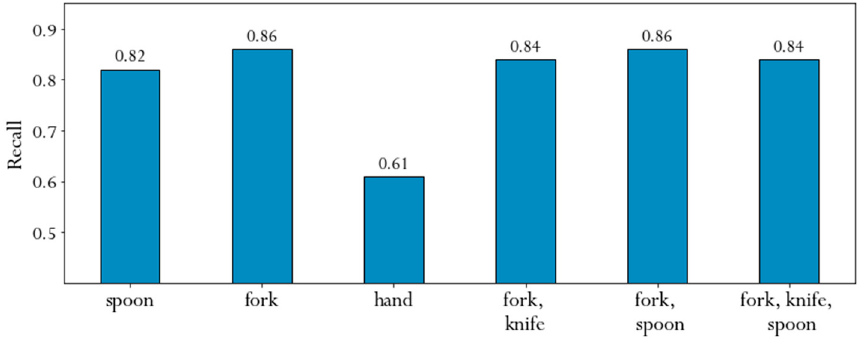
Figure 10. Average recognition for each type of cutlery.